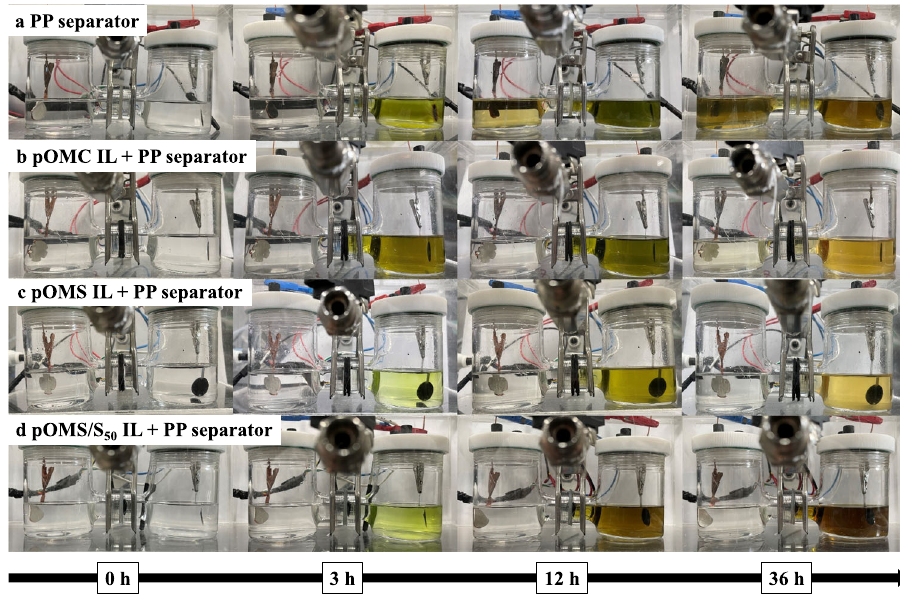
Fig. 3 Lithium polysul fi des diffusion tests using interlayers. Digital photographs of visual electrochemical tests performed in H-type cells at 167.5mA g − 1 for 36 h using the PP (polypropylene) separator fi lm with ( a ) IL-free, ( b ) pOMC IL, ( c ) pOMS IL, and ( d ) pOMS/S 50 IL (Sulfur cathode was placed on the right-hand side and Li metal on the left-hand side of the H-type